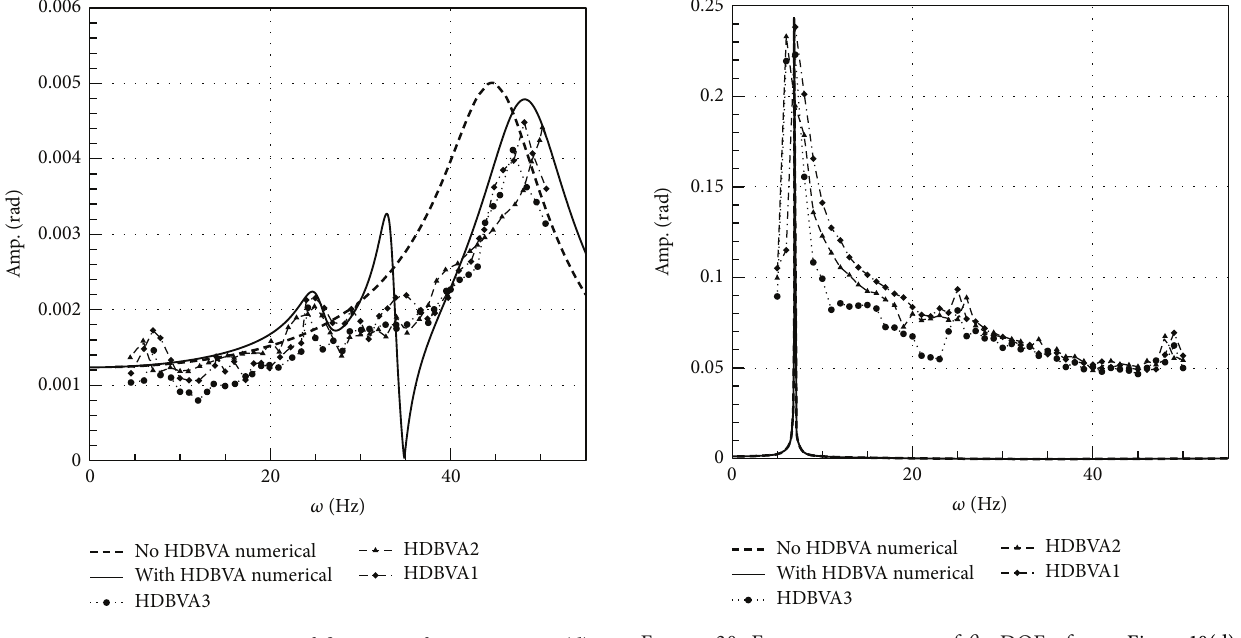
Figure 28: Frequency response of 𝜃 𝑋 DOF of case Figure 10(d), HDBVAs start at the near-force point.